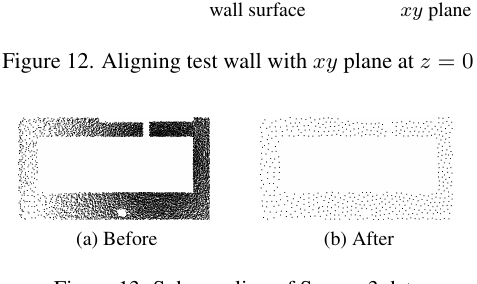
Figure 13. Subsampling of Scanse 3 data